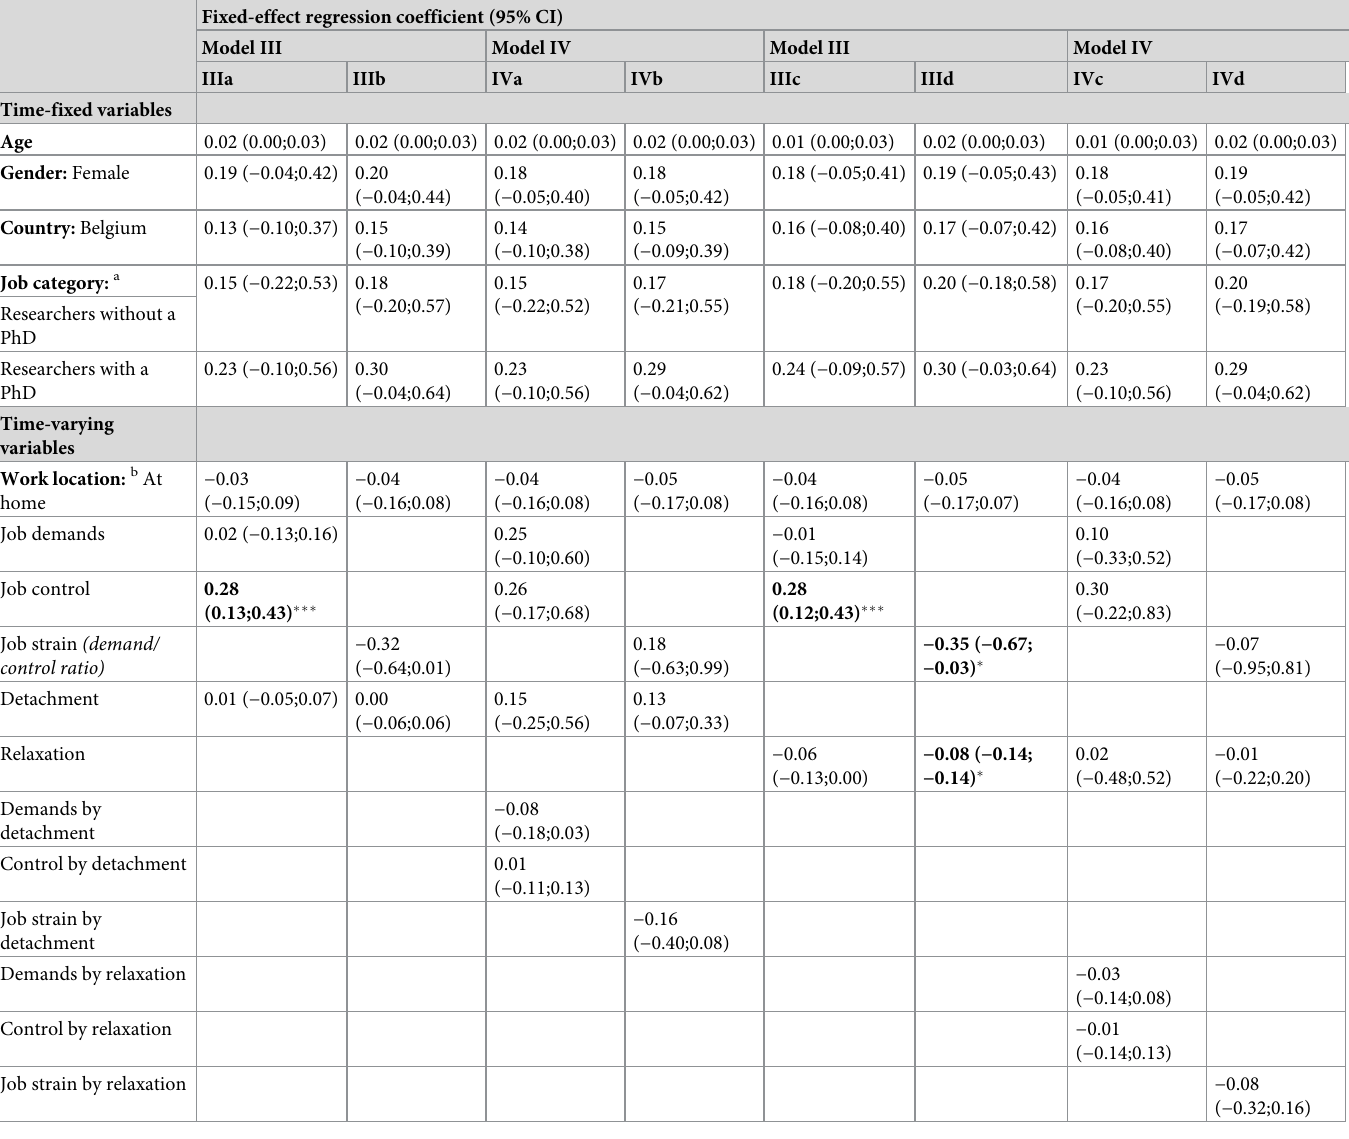
Table 3. Random-intercept models of the associations between day-to-day job demands t1 , job control t1 , job strain t1 , psychological detachment t1 , relaxation t1 , and work engagement t2 . [N = 55; number of item measurements = 2710; CI = confidence